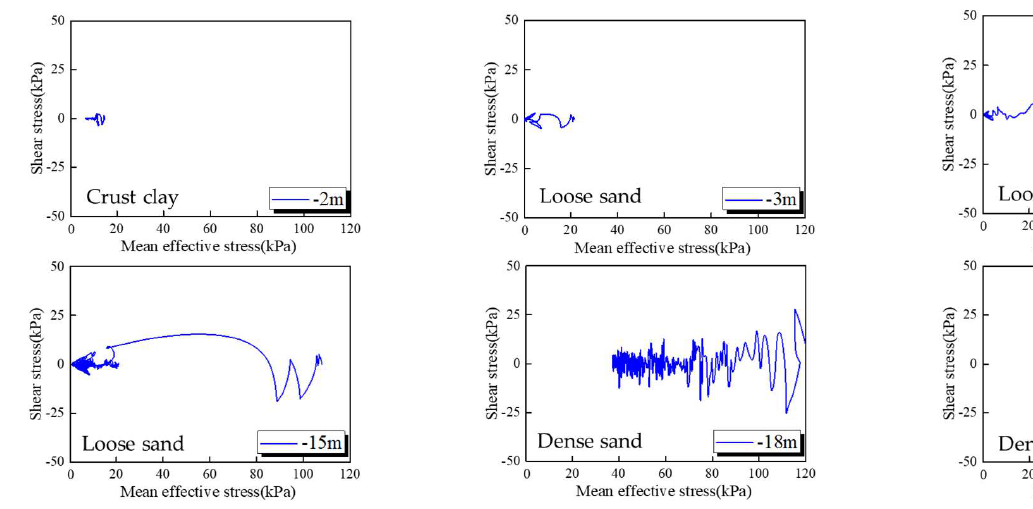
Figure 5. Effective stress paths under the El-Centro motion.